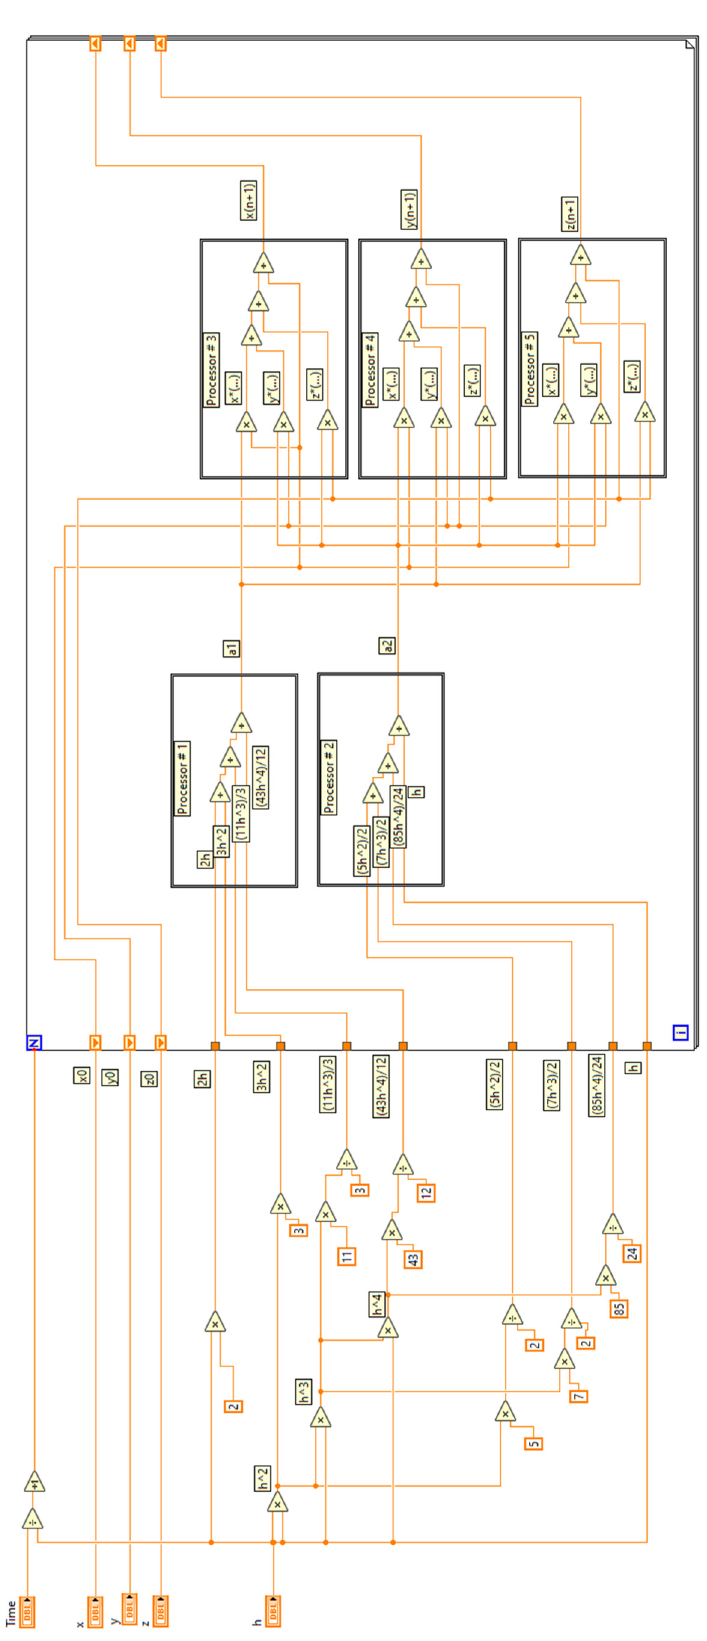
Figure A4. Graphical code for software ODE solver with multi-pipeline parallel 3-processor computational structure for test problem (19). Floating-point data type used.